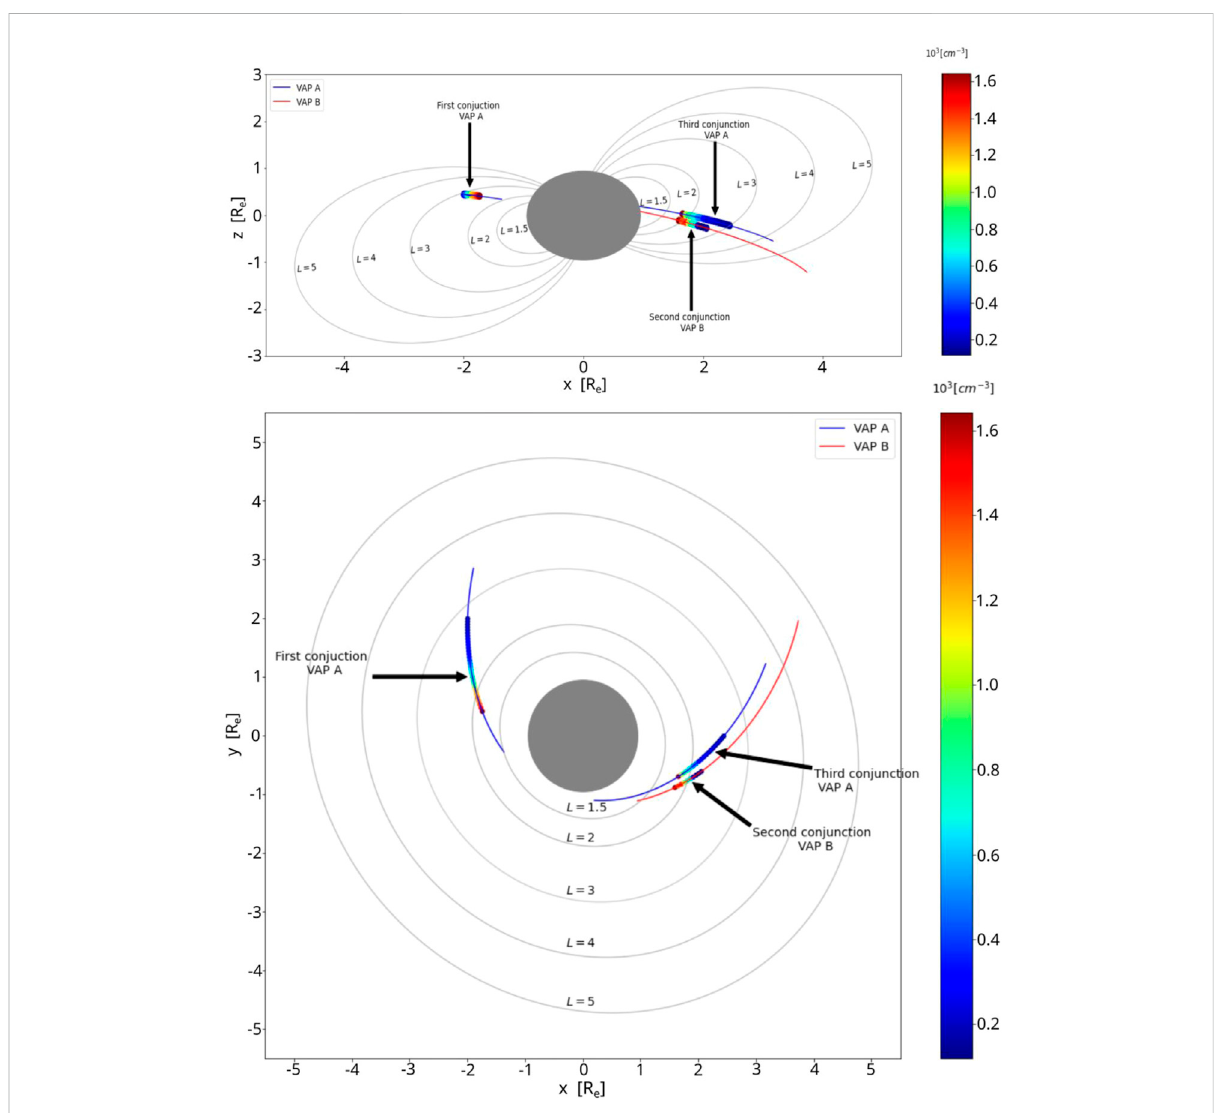
FIGURE 6 Spatialdistributionintwodimensions ofelectrondensity for Lvalues 1.5,2,3,4,and5usingadipolarmodelofEarth ’ smagnetic fi eldlines inthe Solar Magnetic coordinate (SM) for plane YZ (top panel) and XY (bottom panel). The total electron density measurements were obtained from the EMFISIS instrument onboard the Van Allen Probes A (blue lines) and B (red lines). The color bar is the total electron density